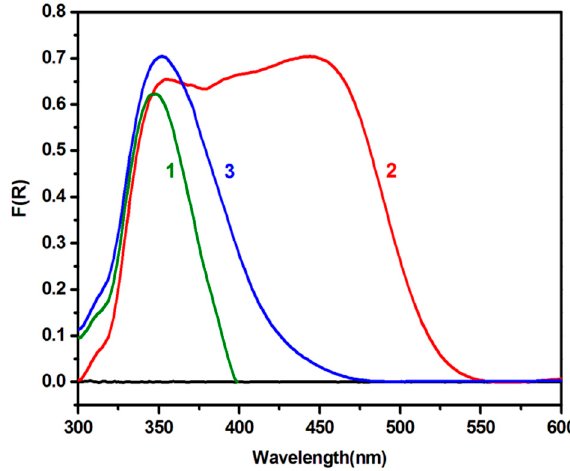
Figure 3. Diffuse-reflection absorption spectra of mesoporous films deposited on FTO electrodes: ( 1 ) TiO 2 ; ( 2 ) CdS/TiO 2 ; and ( 3 ) WO 3 . The peaks at around 350 nm are not real. They are an artifact of the apparatus because of the large absorption at short wavelengths and the ensuing imbalance.